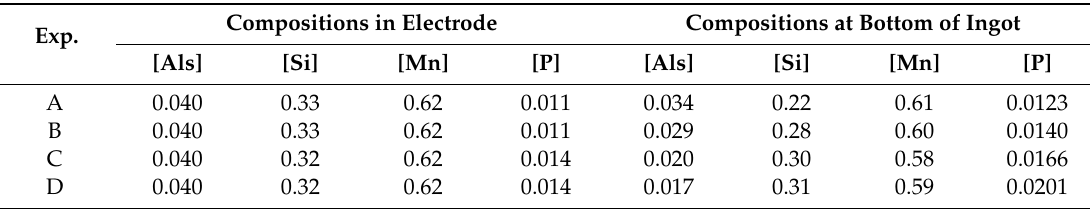
Table 3. Chemical compositions of electrode and ingots